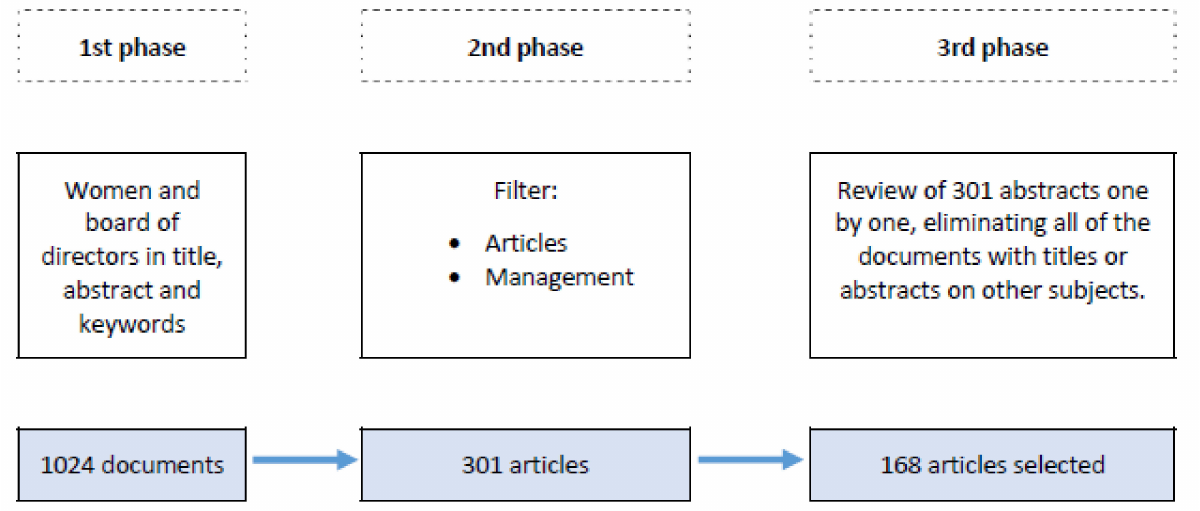
Figure 2. Selection process in the Web of Science of the final sample of documents. Source: Own